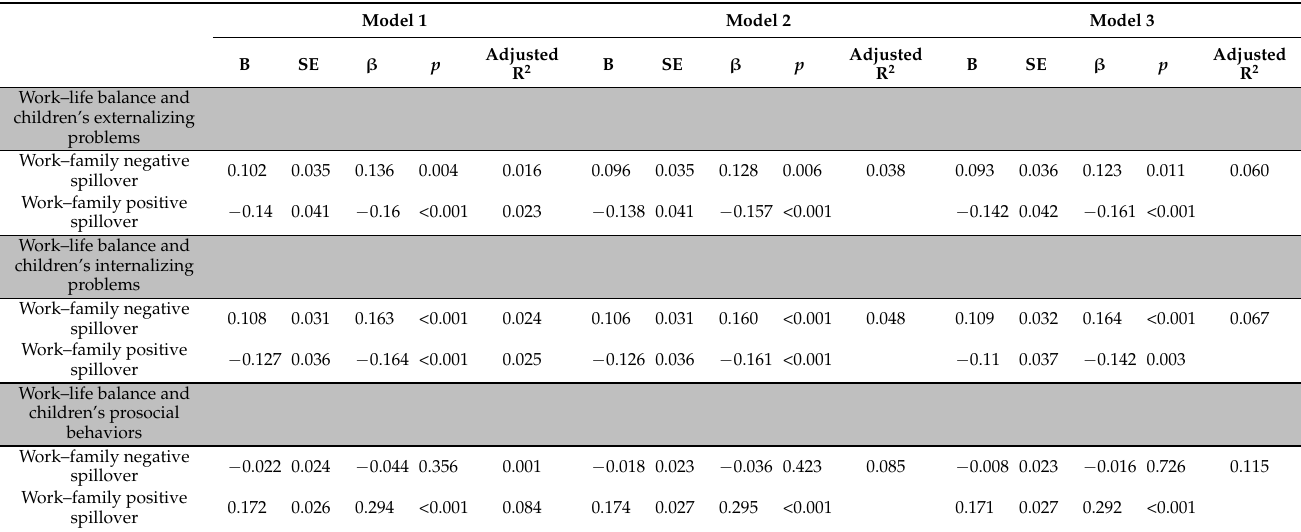
Table 2. Work–life balance and children’s